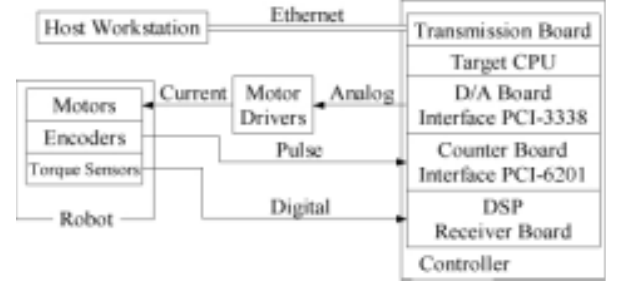
Figure 9 Control system of Gorilla Robot